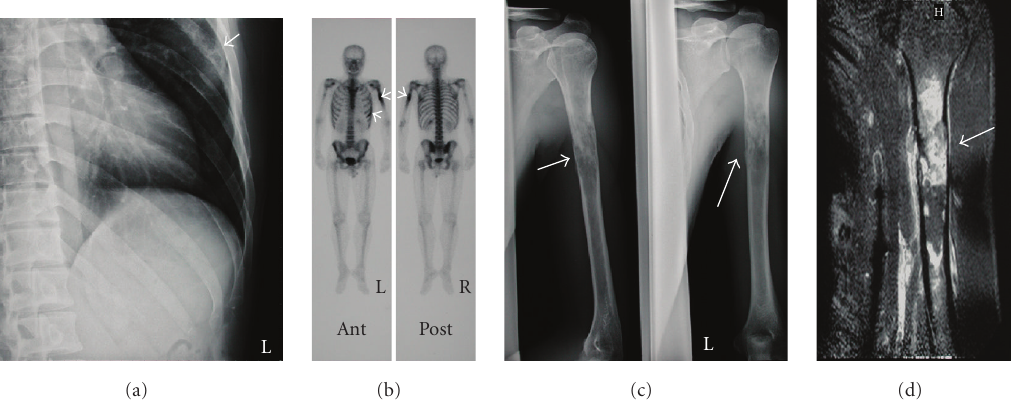
Figure 1: (a) Plain radiogram showing bone destruction of the rib (arrow). (b) Bone scintigram showing increased spots in the bilateral humerus and the left rib (arrow). (c) Plain radiogram of the left humerus showing an osteolytic lesion (arrow). (d) T1 weighted magnetic resonance imaging showing gadolinium enhancement (arrow).